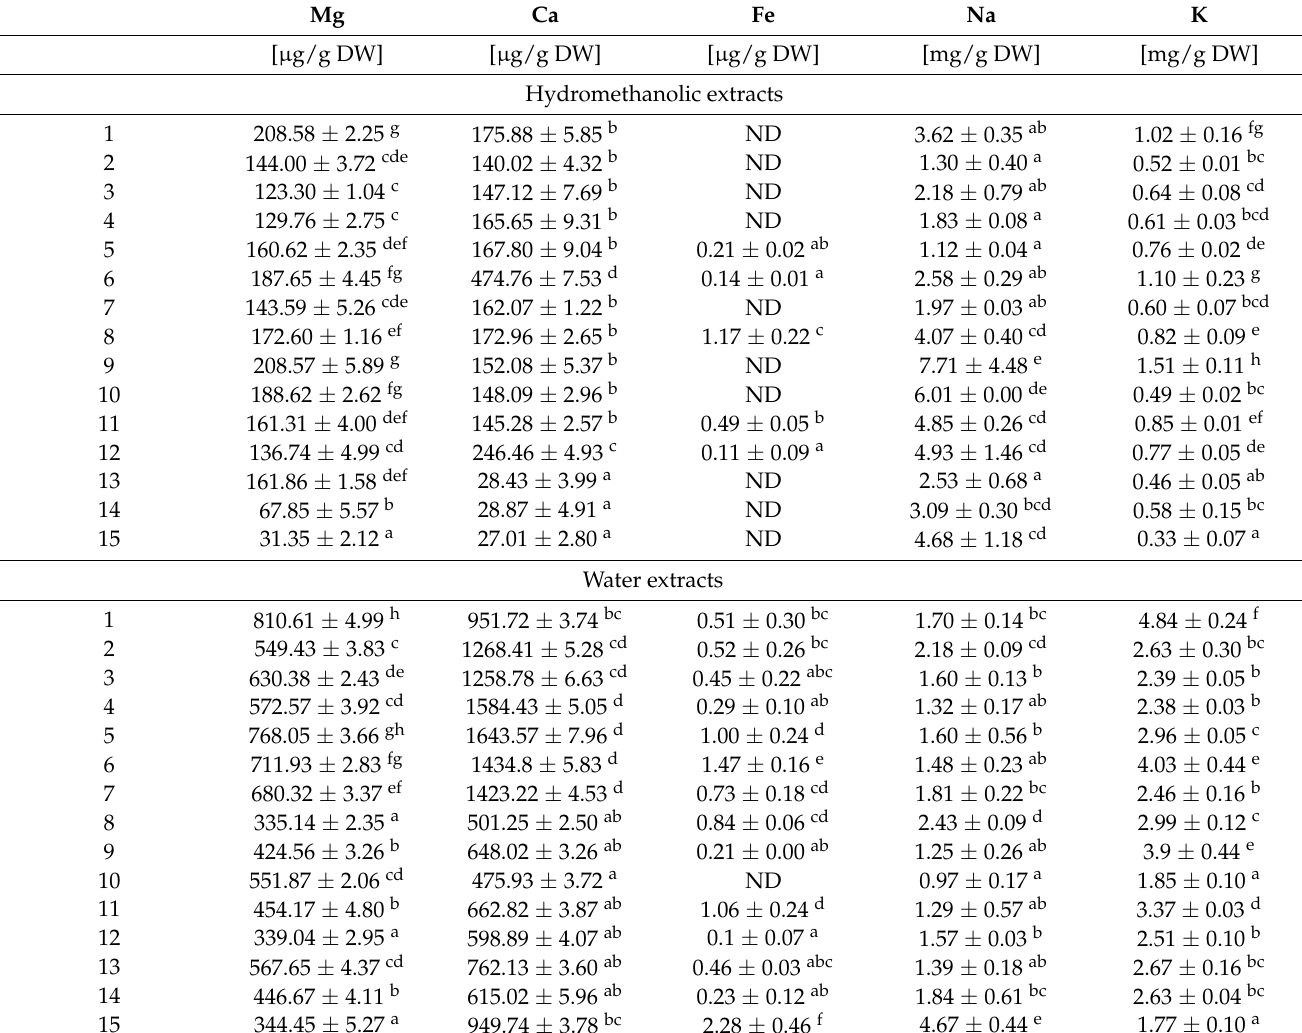
Table 4. The results of determination of elements in R. rosea